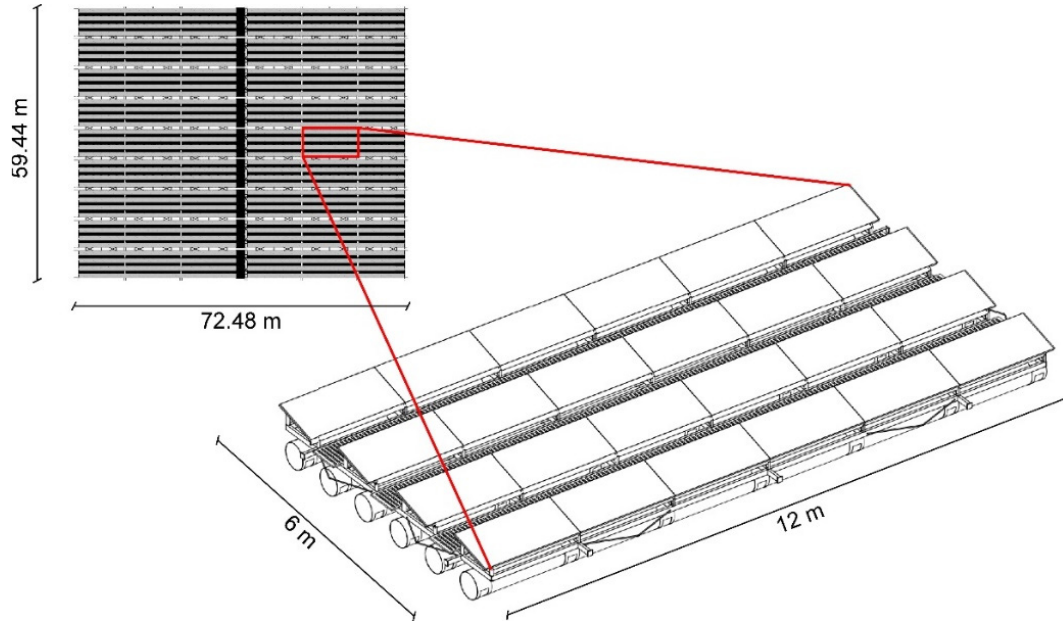
Figure 2. Plane view and single module of PV installation.